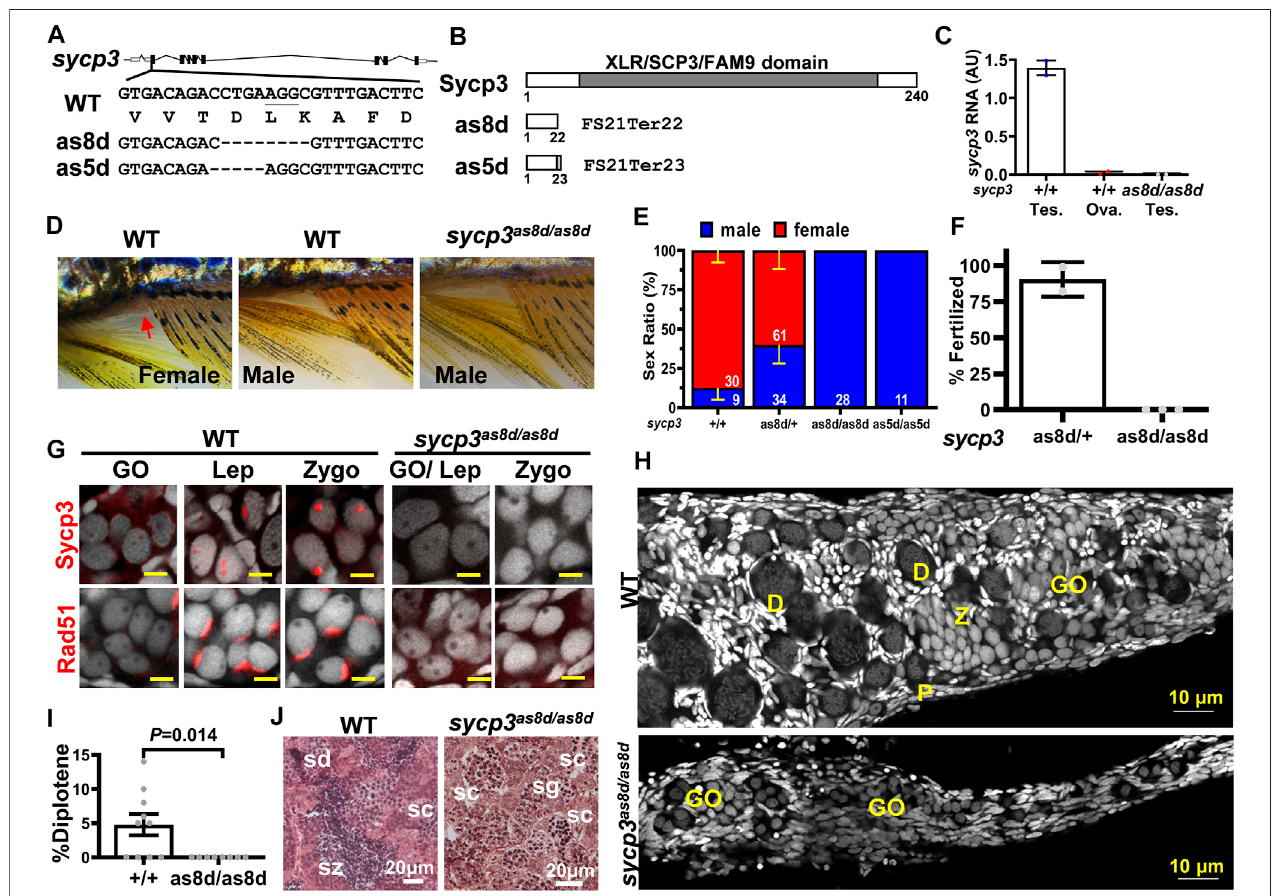
FIGURE 3 | Disruption of sycp3 leads to infertile males with germ cell arrest during meiosis. (A) . Maps of sycp3 and the sites of the mutations. The mutations are located in sycp3 exon 2. (B) . The domain structures of wild type and mutant Sycp3. Both as8d and as5d mutations cause premature protein termination. (C) . The RNA expression of sycp3 decreased in sycp3 mutant. (D) The external morphology of WT and sycp3 mutants. Females have a genital papilla (arrowhead) and yellowish fi ns. Maleslackgenitalpapillaandtheir fi nsarebrownish. (E) .TheSexRatioof sycp3 mutants.Themaleisrepresentedbythebluebar.Redbarrepresentsfemales.The numbers of fi sh used in the analysisare shown inside the bars. (F) . Fertilizationtest showing thefrequency of3-month male fi sh(genotypeindicated belowthe X -axis)to produce offspring. (G) . Immuno fl uorescence staining of 14-dpf WT and sycp3 as8d/as8d gonads with Sycp3 and Rad51 antibodies (Wilson, High et al.). DAPI staining is showninwhitecolor.Thedevelopmentalstagesofthemeioticgermcellsaremarkedatthetopofeach fi gure.GO:gonocyte,Lep:leptotene,Zygo:zygotene. (H) .The1- month WTbut not sycp3 as8d/as8d gonadcontaindiplotenegerm cells. D: diplotene, P:pachytene. (I) .Quantitation ofthe%diplotene germ cellsin agonad.The p values were calculated using Student ’ s t test. (J) . Testicular morphology showing sycp3 as8d/as8d mutant germ cells do not go beyond spermatocytes (sc) while WT germ cells reach spermatozoa (sz). sg: spermatogonia, sd: spermatid.